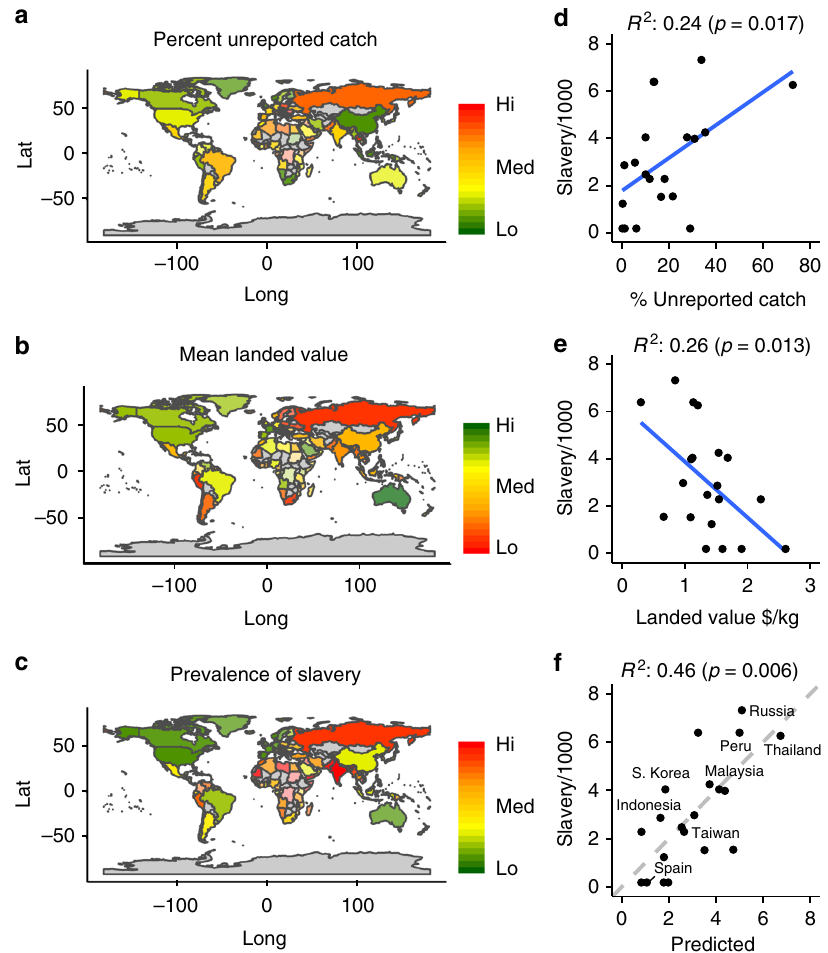
Fig. 1 Global patterns in country-level slavery and fi sheries catch and value. Maps show a percentage of unreported catch, b mean landed catch value per kg, and c national prevalence of slavery, colour-coded by country. Scatterplots show relationship between country-level slavery prevalence and individual fi sheries variables for the 20 largest fi shing countries: d prevalence of slavery per thousand people (Slavery/1000) vs unreported catch (% Unreported catch), e prevalence of slavery vs mean landed value (Landed value $/kg), and f observed against predicted values for a combined model, with selected European, Asian and South American countries labelled. Regression model R 2 values and F -test p values are labelled on